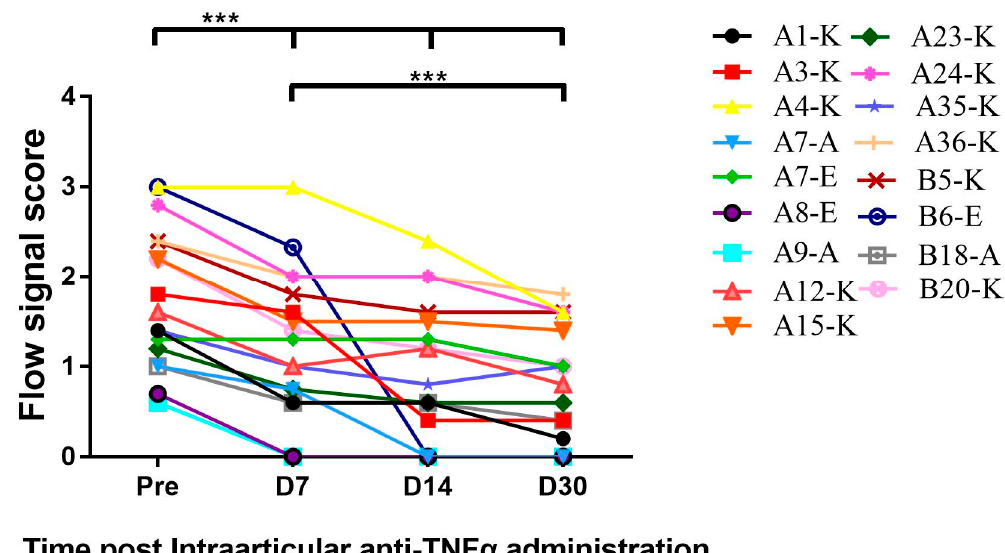
Figure 6. Intra-articular (I.A) administration of the TNF α antagonist decreased synovial vascularity. Synovial vascularity was detected by Power Doppler Ultrasound. As described in Section 2.2, colorful blood flow signals which were found between the capsule and bone surface inside the structures were observed decreased on days 7, 14 and 30 post-I.A administration in comparison to signals pre-treatment, respectively. *** p < 0.001.